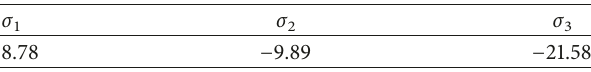
Table 12: The maximum principal stress results (MPa).